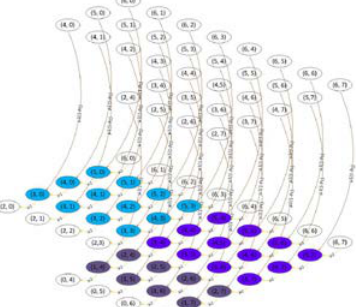
Figure 4 (o) Case 12: System transmit